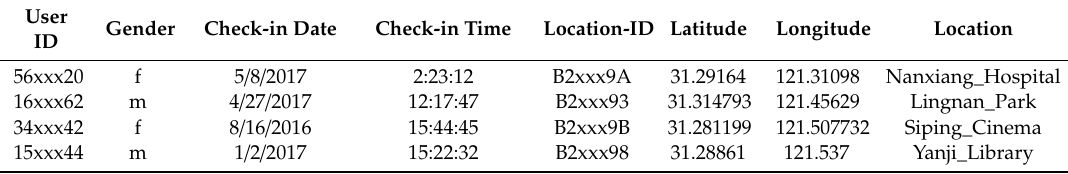
Table 1. The sample of attributes in dataset.